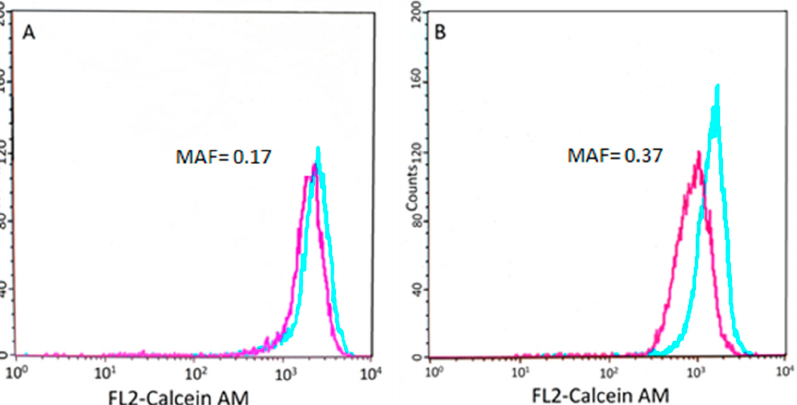
Figure 3. Results of the Calcein AM assay. Flow cytometry histogram showing the calcein fluorescence